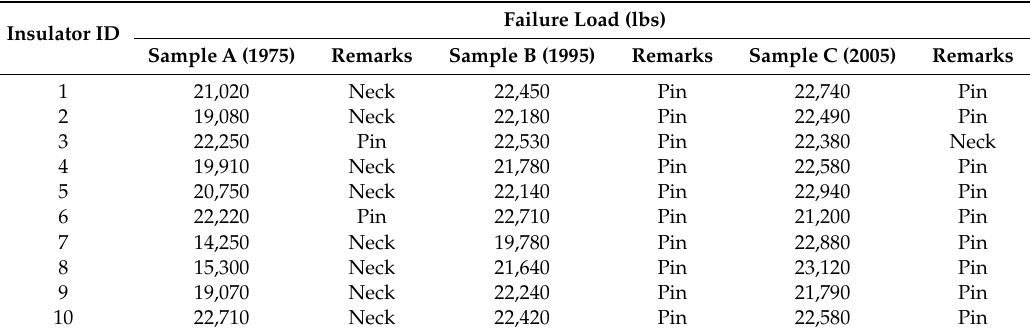
Table 2. Details of the thermal and mechanical (T&M) load test results.